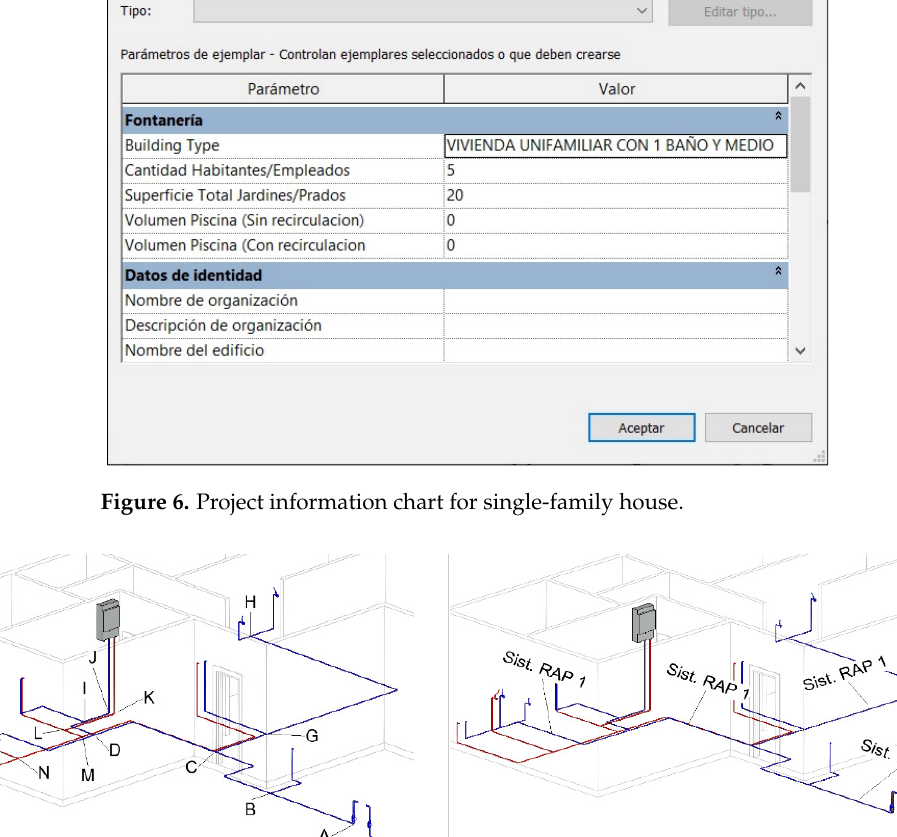
14 of 34 Figure 5. Sanitary plumbing network layout in a single-family house. Table 6. Global data for the single-family house case study. Building Type